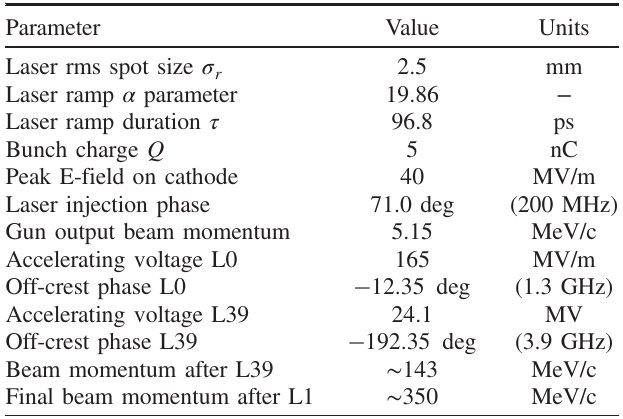
TABLE II. Optimized settings for the accelerator parameters needed to produce and accelerate a drive bunch to ∼ 200 MeV. The parameter α and τ are defined in Eq. (19).